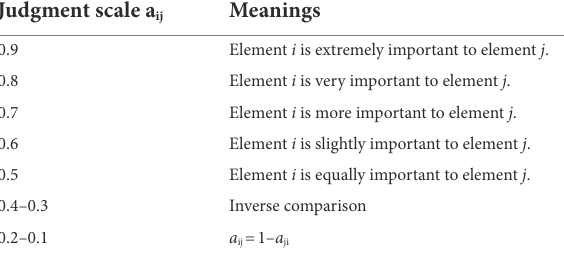
TABLE 1 0.1–0.9 nine scales and their